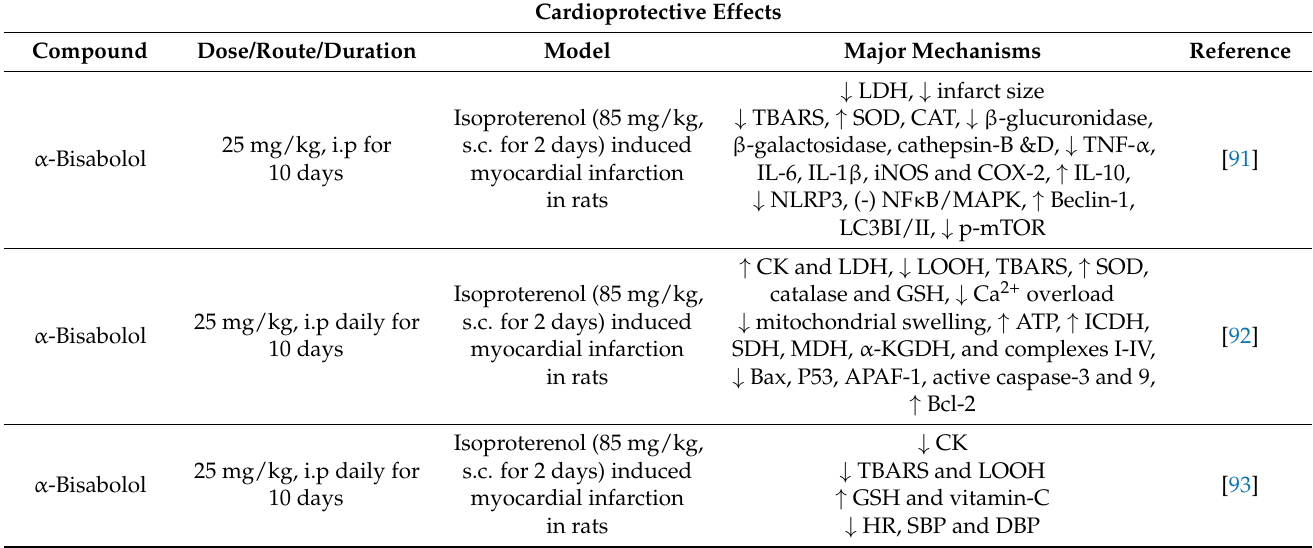
Table 7. Cardioprotective effects and mechanisms of α -Bisabolol. Cardioprotective